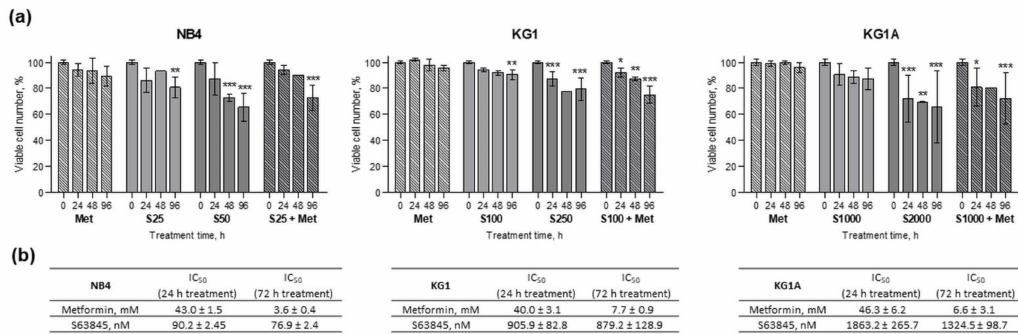
Figure 1. Effect of metformin and MCL-1 inhibitor S63845 on myeloid leukemia cell viability and induced cytotoxicity. ( a ) NB4, KG1 and KG1A cells were treated with 10 mM metformin and with different concentrations of MCL-1 inhibitor S63845 (S25–25 nM of S63845, etc.). Cell survival was evaluated by trypan blue exclusion test. Viability data were normalized to untreated controls. Results are mean ± S.D. ( n ≥ 3). ( b ) Antiproliferative IC 50 values for metformin and S63845 were evaluated using XTT Cell Proliferation Assay Kit (ATTC). Average ± S.D. is presented ( n ≥ 3, except where columns are without error bars n = 1). Note: * denotes significant difference between treated vs. control cells with p < 0.05, ** denotes significant difference with p < 0.01, and *** denotes significant difference with p < 0.005, as evaluated using 1-way ANOVA with Dunnett post hoc